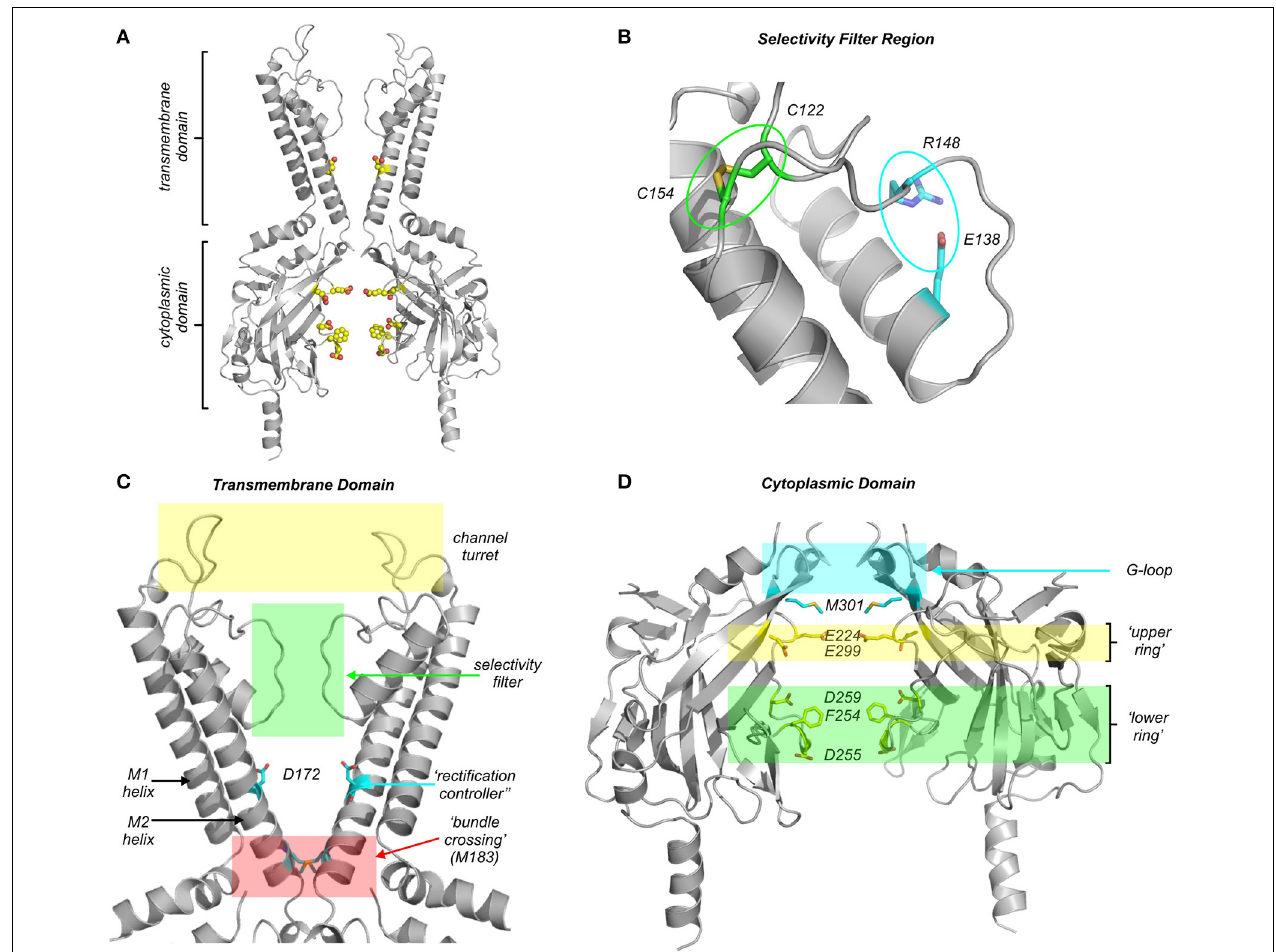
FIGURE 2 | Modular architecture of Kir channels, and the location of residues essential for polyamine block. (A) Overall structural arrangement of the transmembrane (TMD) and cytoplasmic (CTD) domains of Kir channels. All structural models are constructed based on the Kir2.2 channel co-crystallized with di-C8-PIP2 (Hansen et al., 2011). Highlighted residues are D172, E224, F254, D255, D259, and E299 [labeled in more detail in (C,D) ]. (B) Expanded view of the selectivity filter region, highlighting the disulfide bond